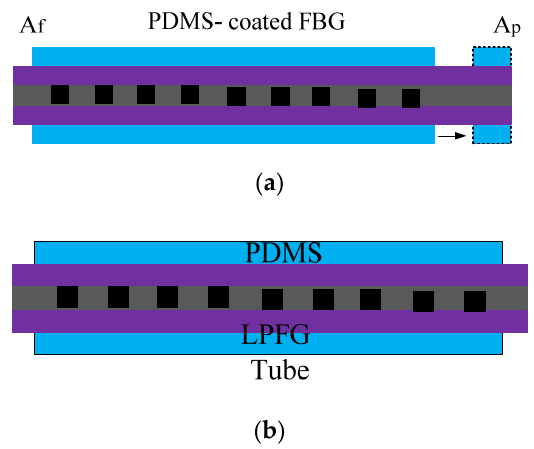
Figure 6. The schematic diagram of sensors: ( a ) FBG sensor coated with PDMS [32]; ( b ) LPFG with a tube filled with PDMS [33] .